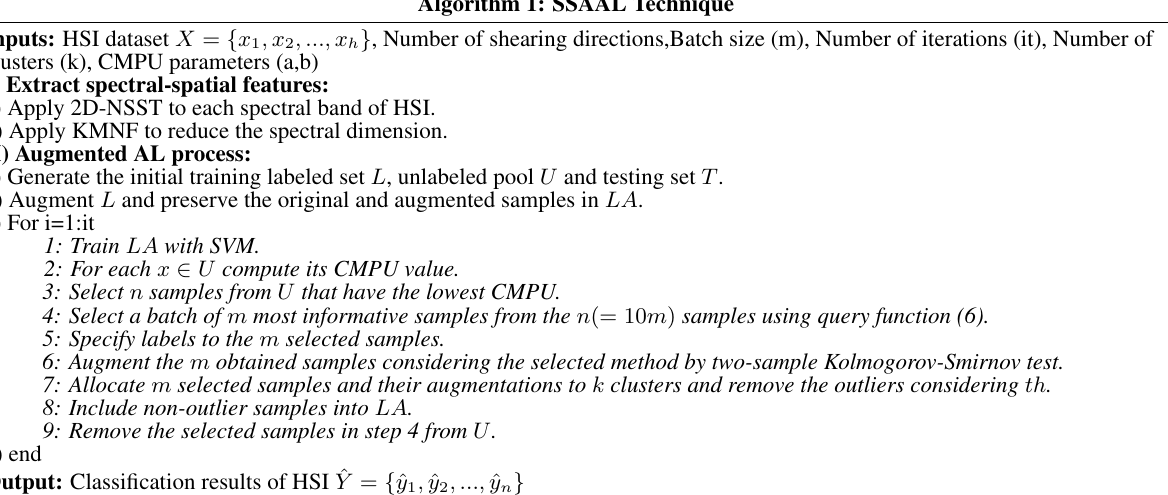
Algorithm 1: SSAAL Technique